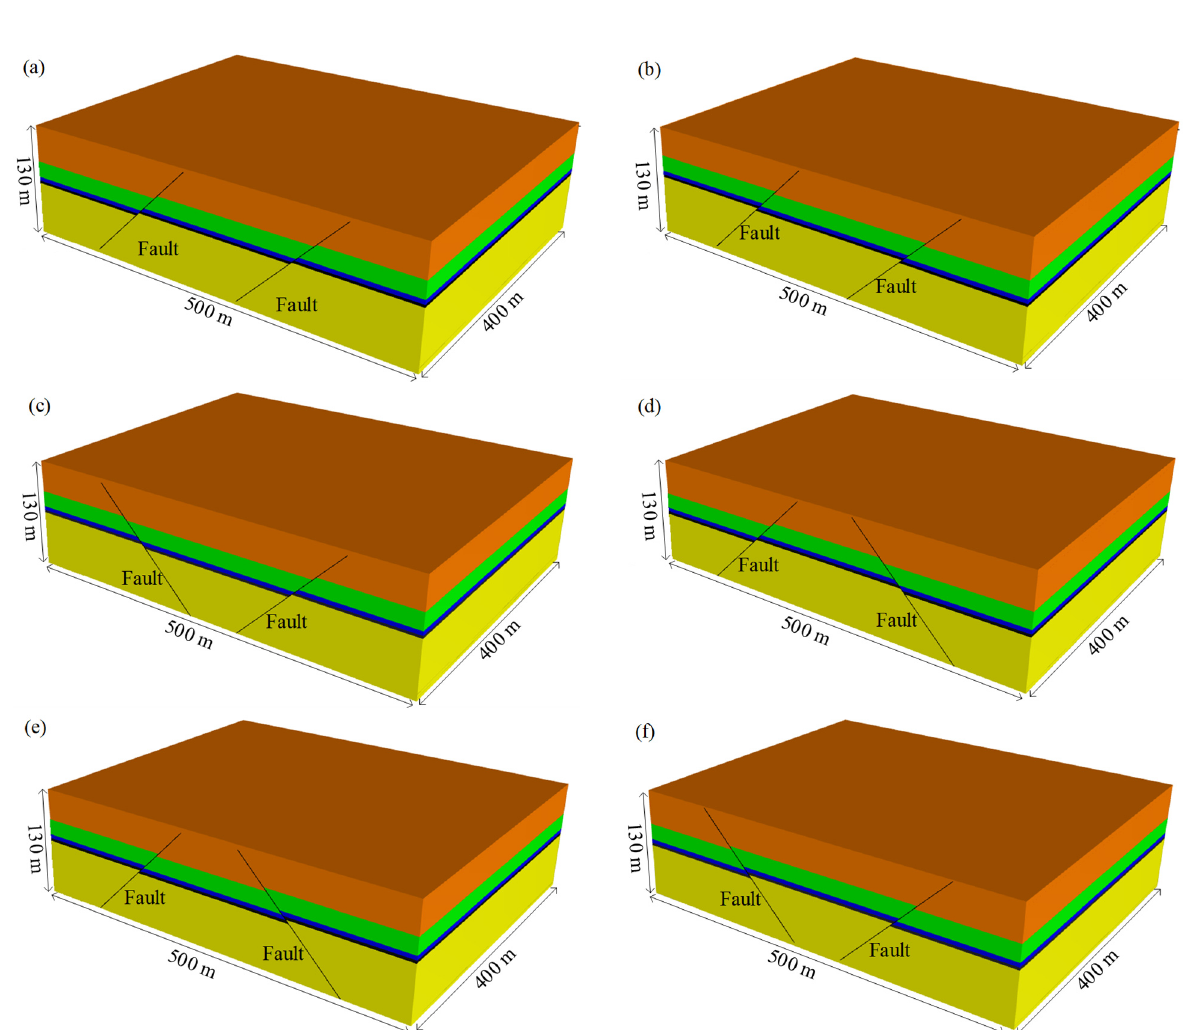
Figure 11. The numerical models of the different two combined faults. ( a ) Stair-stepping fault model. ( b ) Imbricate fault model. ( c ) Graben fault model. ( d ) Horst fault model. ( e ) Back thrust fault model. ( f ) Ramp fault model. The blocks represent overburdens; the blocks represent main roofs; the blocks represent immediate roofs; the blocks represent coal seams; and the blocks represent floors. Table 3. Orthogonal test factor levels and model parameters.